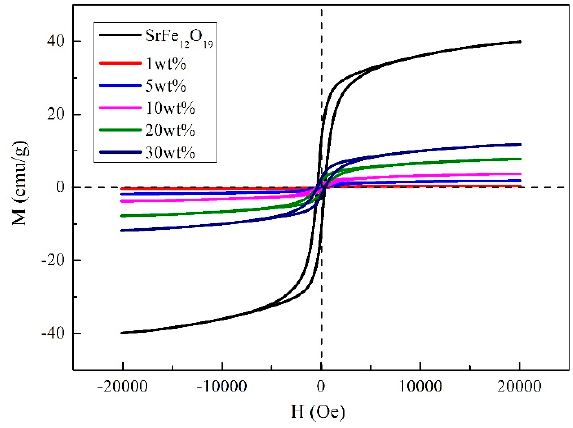
Figure 4. Hysteresis loops of SrFe 12 O 19 /semi-conductive composites.